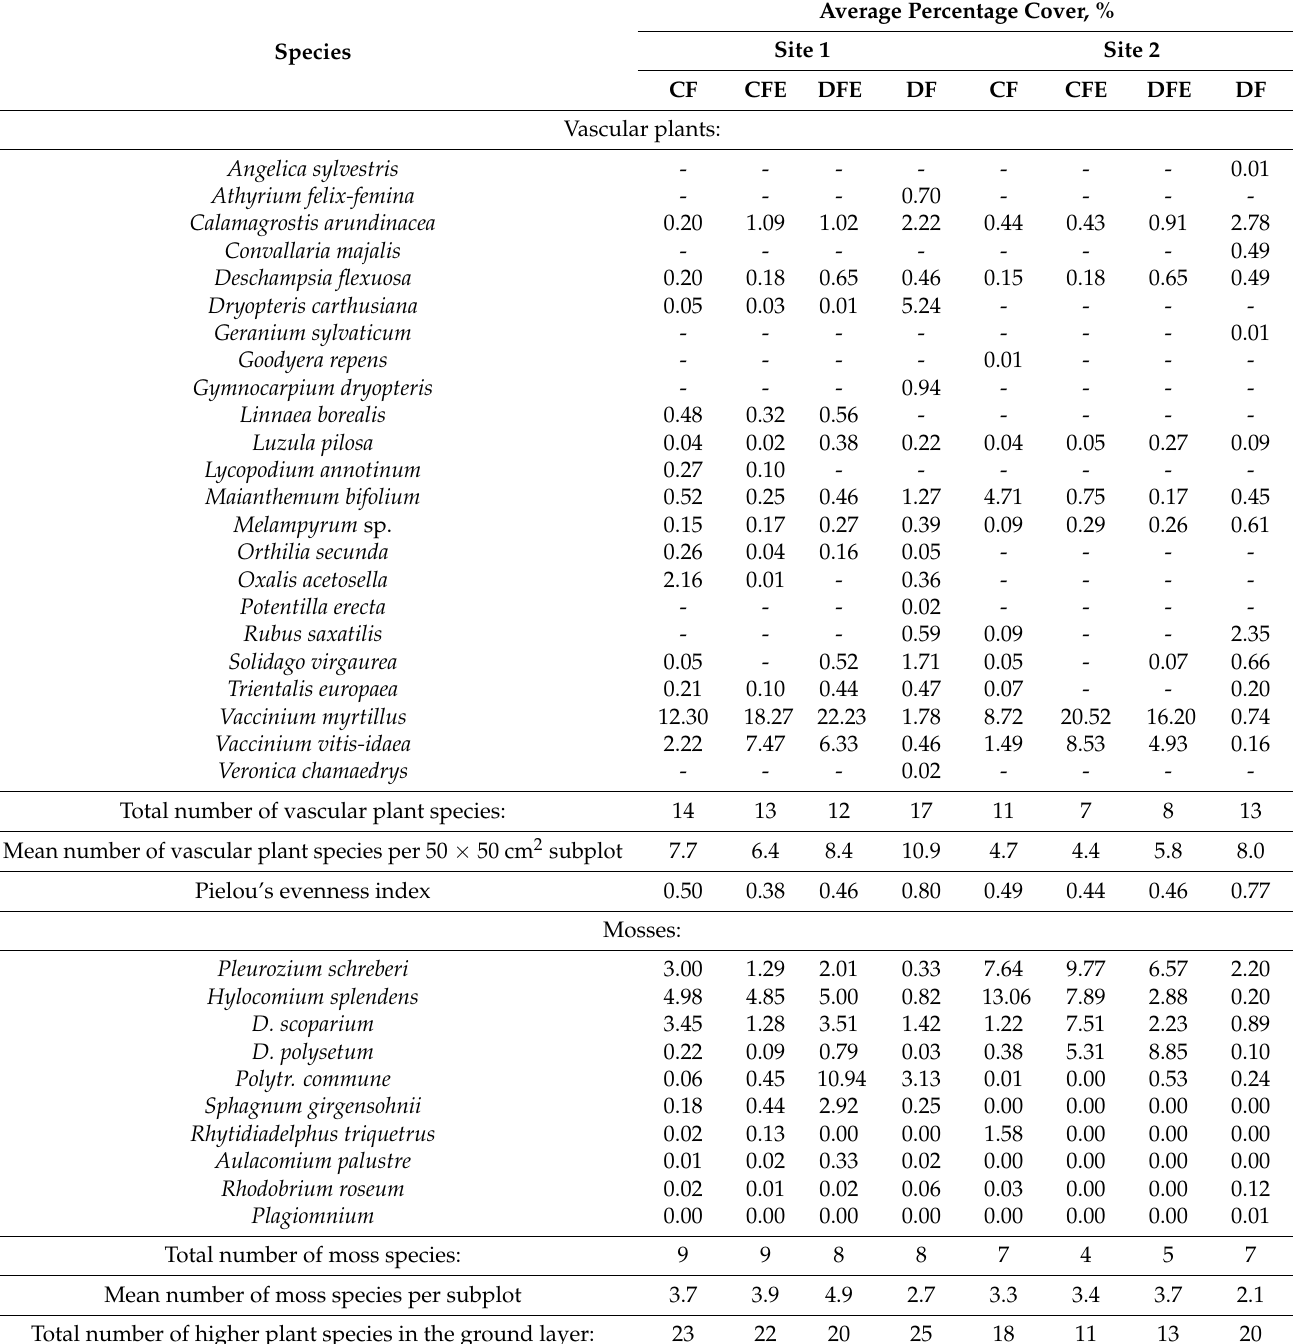
Table 2. Composition and average percentage covers of plants in ecotone complex zones.